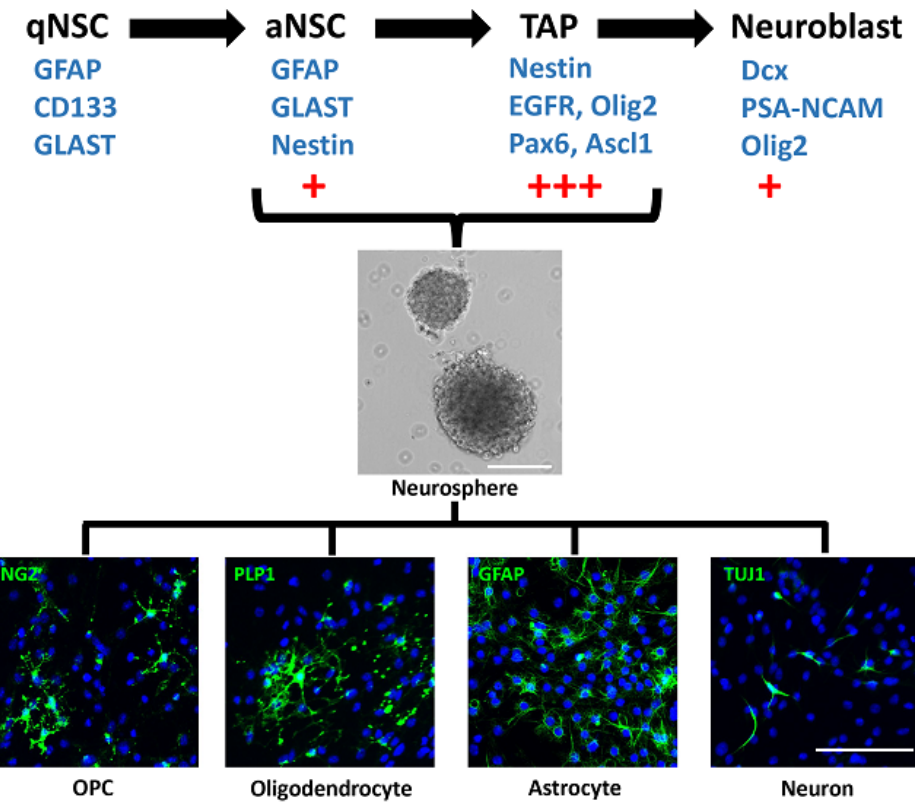
Figure 1. Stages of neural stem cells and their markers. The different stages of neural stem cells (NSCs) are identified by expression of markers and level of proliferation. Only activated NSCs (aN ‐ SCs) and transit ‐ amplifying progenitors (TAPs) grow as neurospheres and differentiate into the ol ‐ igodendroglial, astroglial, and neuronal lineages in vitro. OPC, oligodendrocyte progenitor